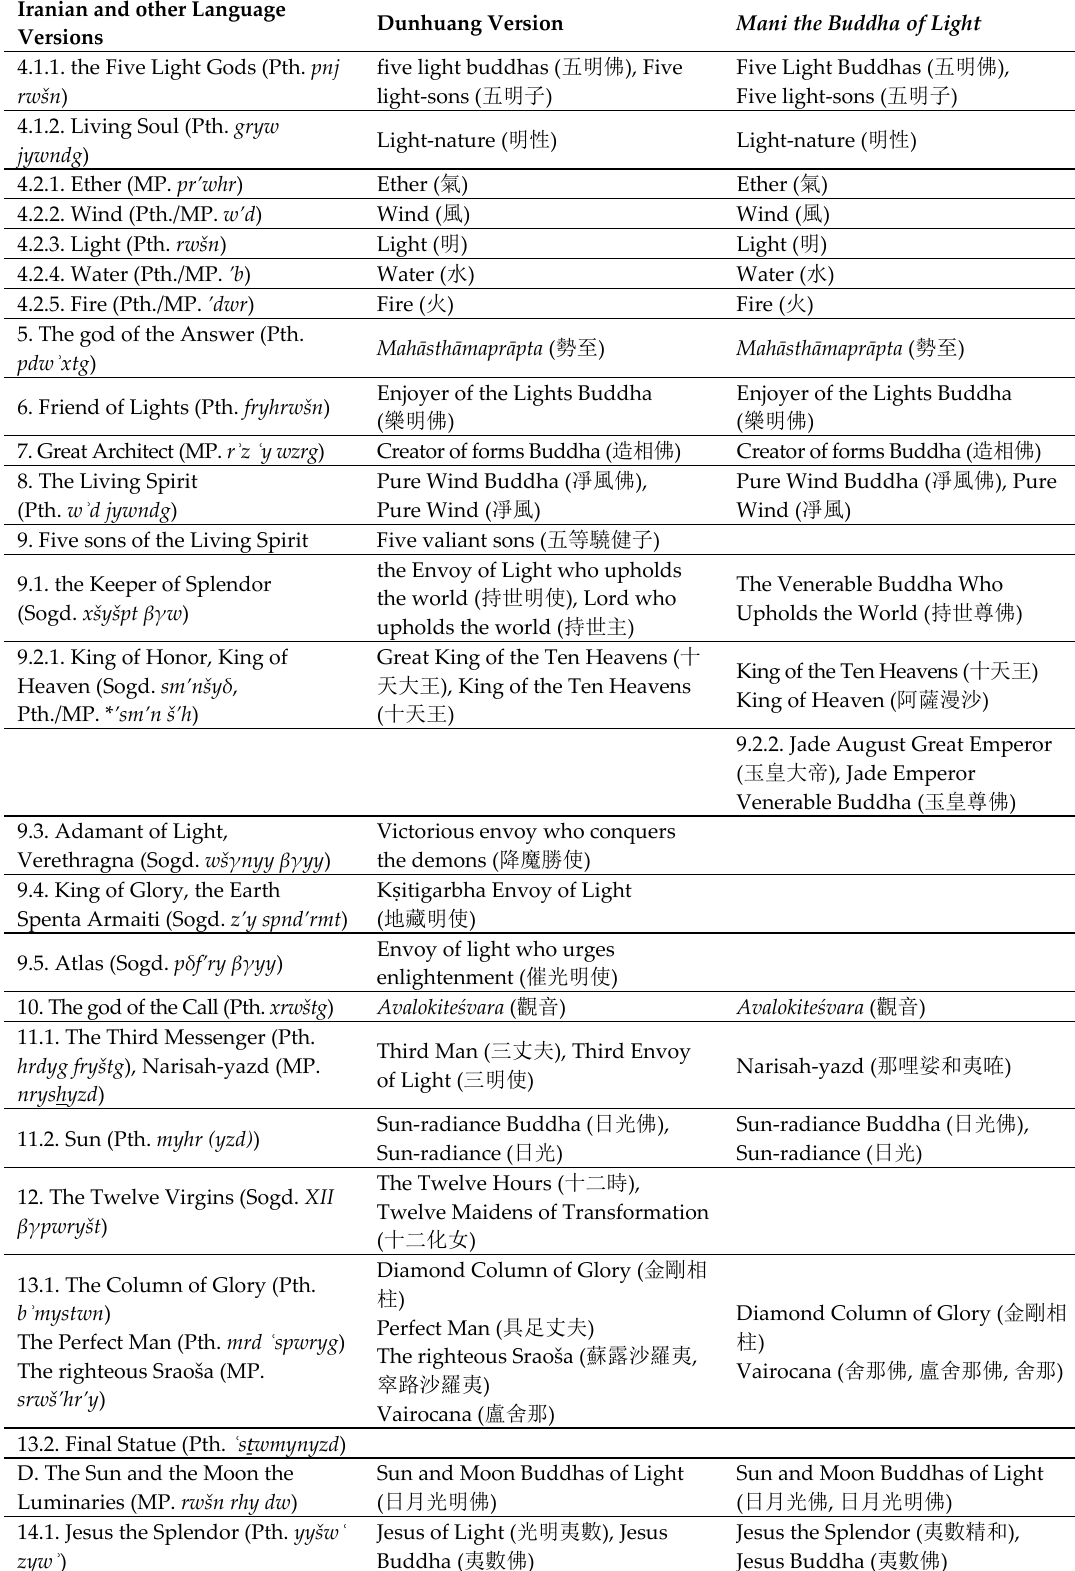
Religions 2017 , 8 , x FOR PEER